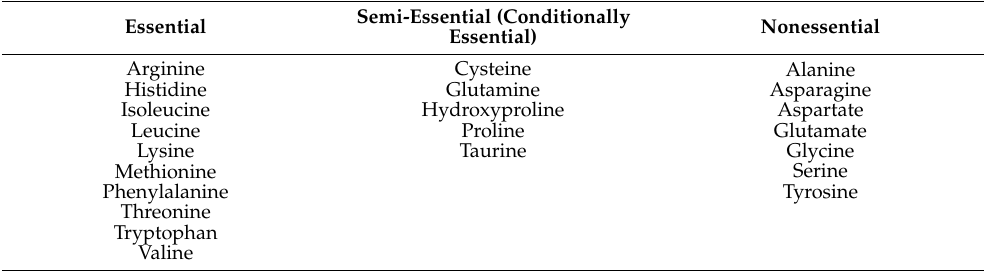
Table 2. Amino acid classification by the possibility of synthesis in